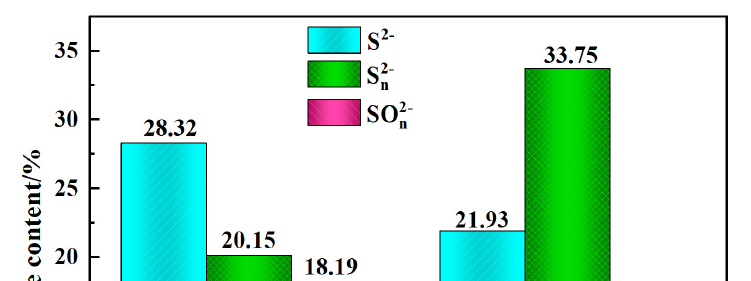
Figure 9. S2p XPS spectra of cerussite treated with different conditions: ( a ) cerussite, ( b ) cerussite + Pb 2+ , ( c ) cerussite + Na 2 S, and ( d ) cerussite + Pb 2+ + Na 2 S.